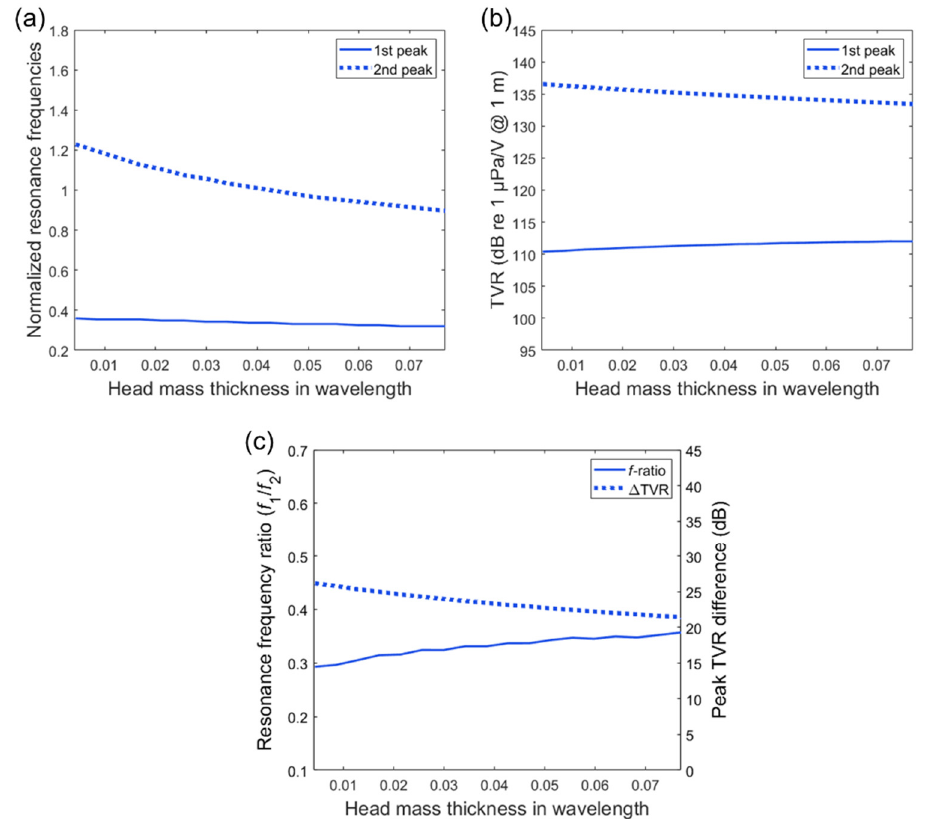
Figure 7. Transmitting characteristics as a function of the head mass thickness. The thickness dimension is presented in wavelength and the frequency values are normalized by the fundamental longitudinal resonance frequency: ( a ) normalized resonance frequency variation; ( b ) TVR peak variation; ( c ) variation in resonance frequency ratio ( f 1 / f 2 ) and TVR difference.